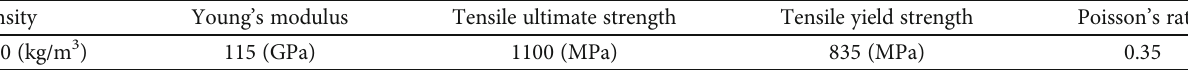
Table 2: The main parameters of VT6 titanium